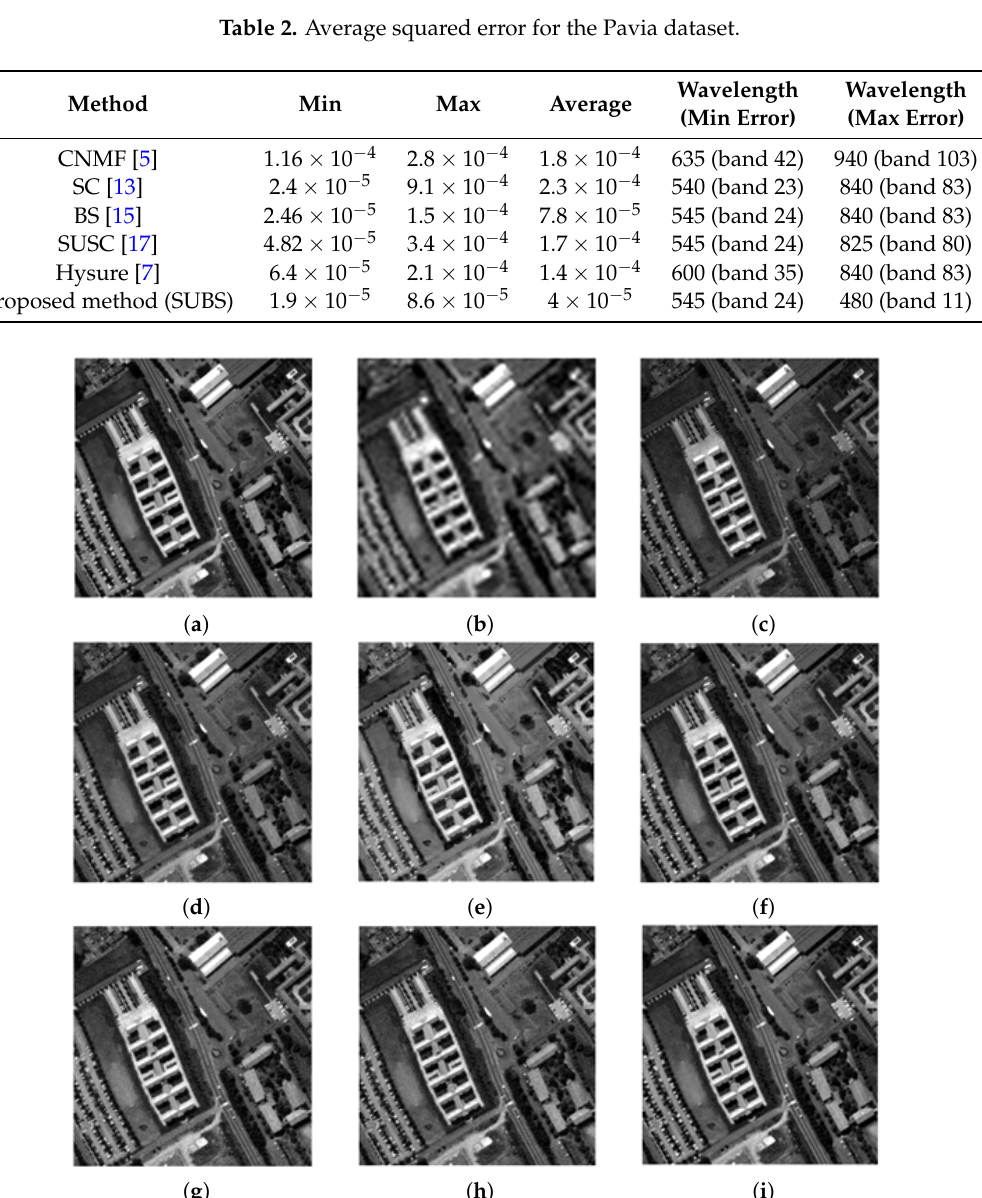
Figure 5. ( a ) Band 40 of the Pavia ground truth image(256 × 256); ( b ) band 40 of the LRHSI; ( c ) band 2 of the MSI. Spatial resolution enhancement results of band 40 of the HSI: ( d ) Coupled Non-Negative Matrix Factorization ; ( e ) Sparse CodingC; ( f ) Bayesian Sparse; ( g ) spectral Unmixing Sparse Coding; ( h ) Hysure; ( i ) Spectral Unmixing Bayesian